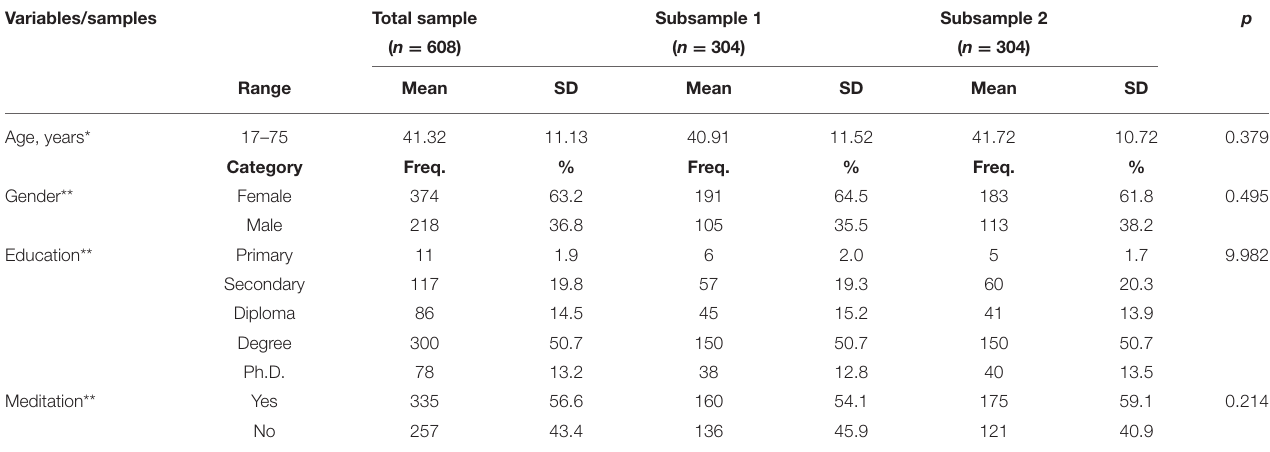
TABLE 1 | General socio-demographic variables of the participants according to subsample.